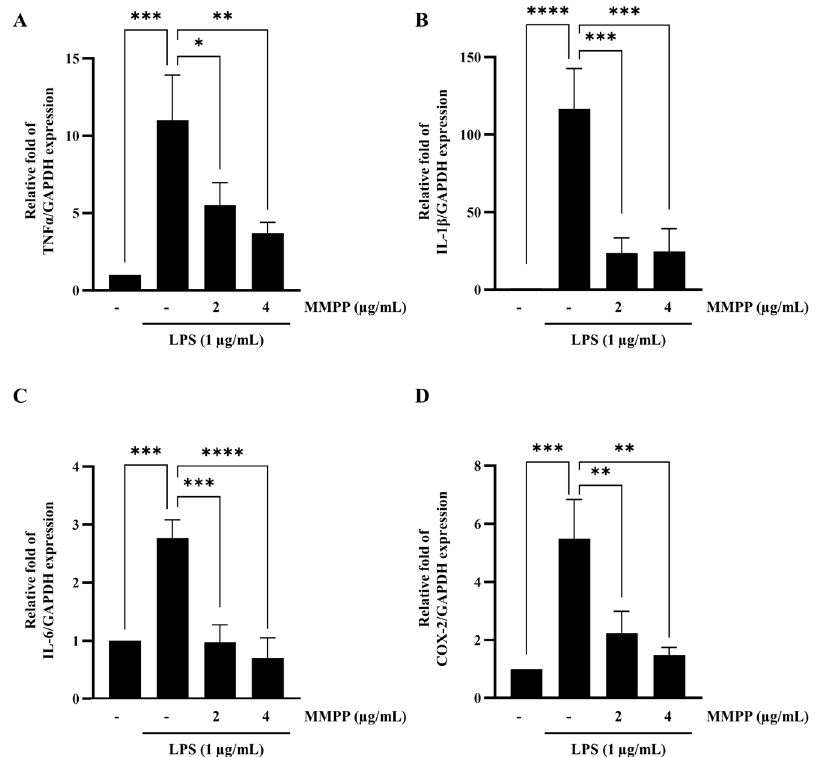
Figure 2. Inhibitory effects of MMPP on the expression of pro-inflammatory genes in LPS-stimulated THP-1 cells. ( A – D ) THP-1 cells were pretreated with MMPP (2 and 4 µ g/mL) for 1 h and treated with LPS (1 µ g/mL) for 2 h. The mRNA levels of TNF- α , IL-1 β , IL-6, and COX-2 were determined by RT-qPCR. Data are presented as the mean ± SD ( n = 3); * p < 0.05, ** p < 0.01, *** p < 0.001, and **** p < 0.0001 by one-way ANOVA.